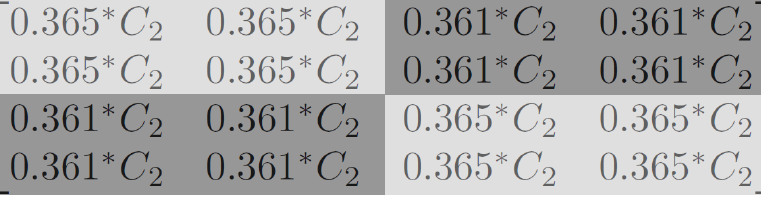
Figure 16. The 4 × 4 region after encoding and decoding; the distribution is